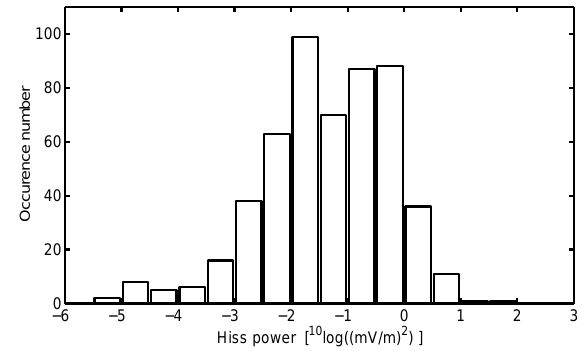
Fig. 11. The distribution of the estimated background lower hybrid hiss wave power for the Cluster LHC